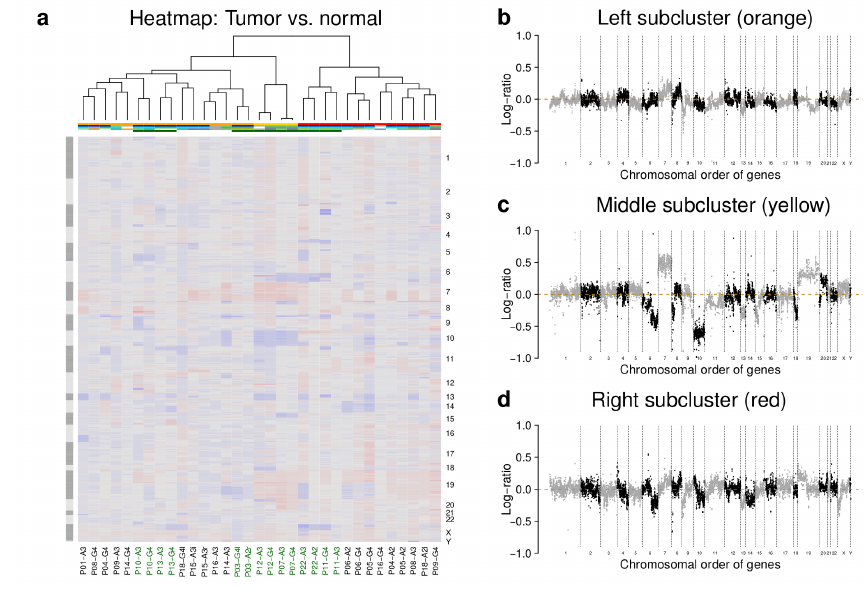
Figure 2. Genome-wide gene copy number alterations of individual astrocytomas. ( a ) heatmap of individual tumor aCGH profiles. Tumors were clustered based on the similarity of their aCGH profiles (columns) and their corresponding gene-specific copy number values are visualized from chromosome 1 to X (rows). The heatmap represents gene deletions (blue regions), gene duplications (red regions), and genes with unchanged copy number (grey regions) in tumors compared to normal DNA. Three major tumor-specific aCGH clusters are labeled in the first colored line below the dendrogram at the top of the heatmap (left subgroup: orange, middle subgroup: yellow, right subgroup: red), the second line represents the IDH1 mutation status (mutated: blue, wt: grey), the third line represents the estimated tumor content of the sample (grey: less than 25%, green: 25–75%, light green: more than 75%, white: not available), the fourth line contains information about treatment before surgery (grey: no, pink: surgery, orange: surgery and irradiation, lilac: surgery, irradiation and temozolomide, blue: surgery, irradiation and non-temozolomide chemotherapy, white: not available), and patient-specific initial and recurrent tumors that directly clustered together are labeled in green in the fifth line. Alternating dark and light grey bars left to the heatmap visualize the individual chromosomes. Tumor identifiers are shown below the heatmap encoding the patient identifier (Px: x specifies the patient) followed by the tumor type (A2: astrocytoma WHO grade II, A3: astrocytoma WHO grade III, G4: glioblastoma WHO grade IV; additional extensions of ‘i’ (initial), ‘r’ (recurrent), and ‘l’ (last recurrent) are added when a patient had more than two tumors). ( b – d ) characteristic average aCGH profiles of the three major aCGH subgroups. Gene copy number alterations are quantified by average log2-ratios of tumor versus normal and plotted in chromosomal order of genes. Chromosomes are separated by alternating grey and black dots and chromosome ends are marked by black dotted vertical lines. Strong deviations of average log-ratios from zero indicate deletions (negative log-ratio) and duplications (positive log-ratio) in the left subgroup ( b ), middle subgroup ( c ), and right subgroup ( d